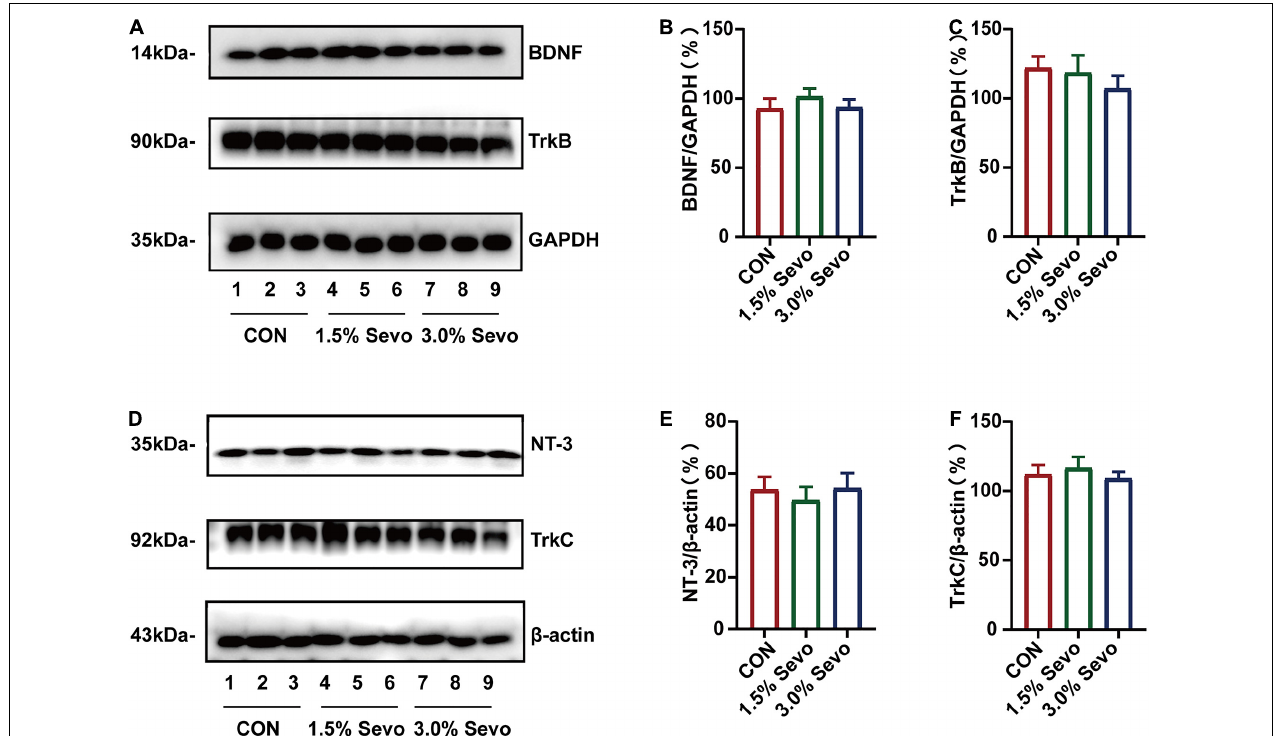
FIGURE 6 | Sevoflurane exposure does not induce the reduction of BDNF/TrkB and NT-3/TrkC in the hippocampi of adult mice. (A) Representative WB images of BDNF and TrkB expression in adult mice. Quantitative analysis of BDNF (B) and TrkB (C) . GAPDH was used as an internal standard. (D) Representative WB images of NT-3 and TrkC expression in adult mice. Quantitative analysis of NT-3 (E) and TrkC (F) . β -actin was used as an internal standard. Values are the mean ± S.E.M ( n = 9/group). BDNF, brain-derived neurotrophic factor; TrkB, tyrosine receptor kinase B; NT-3, Neurotrophin-3; TrkC, tyrosine receptor kinase C; CON, control group; 1.5% Sevo, 1.5% sevoflurane group; 3.0% Sevo, 3.0% sevoflurane